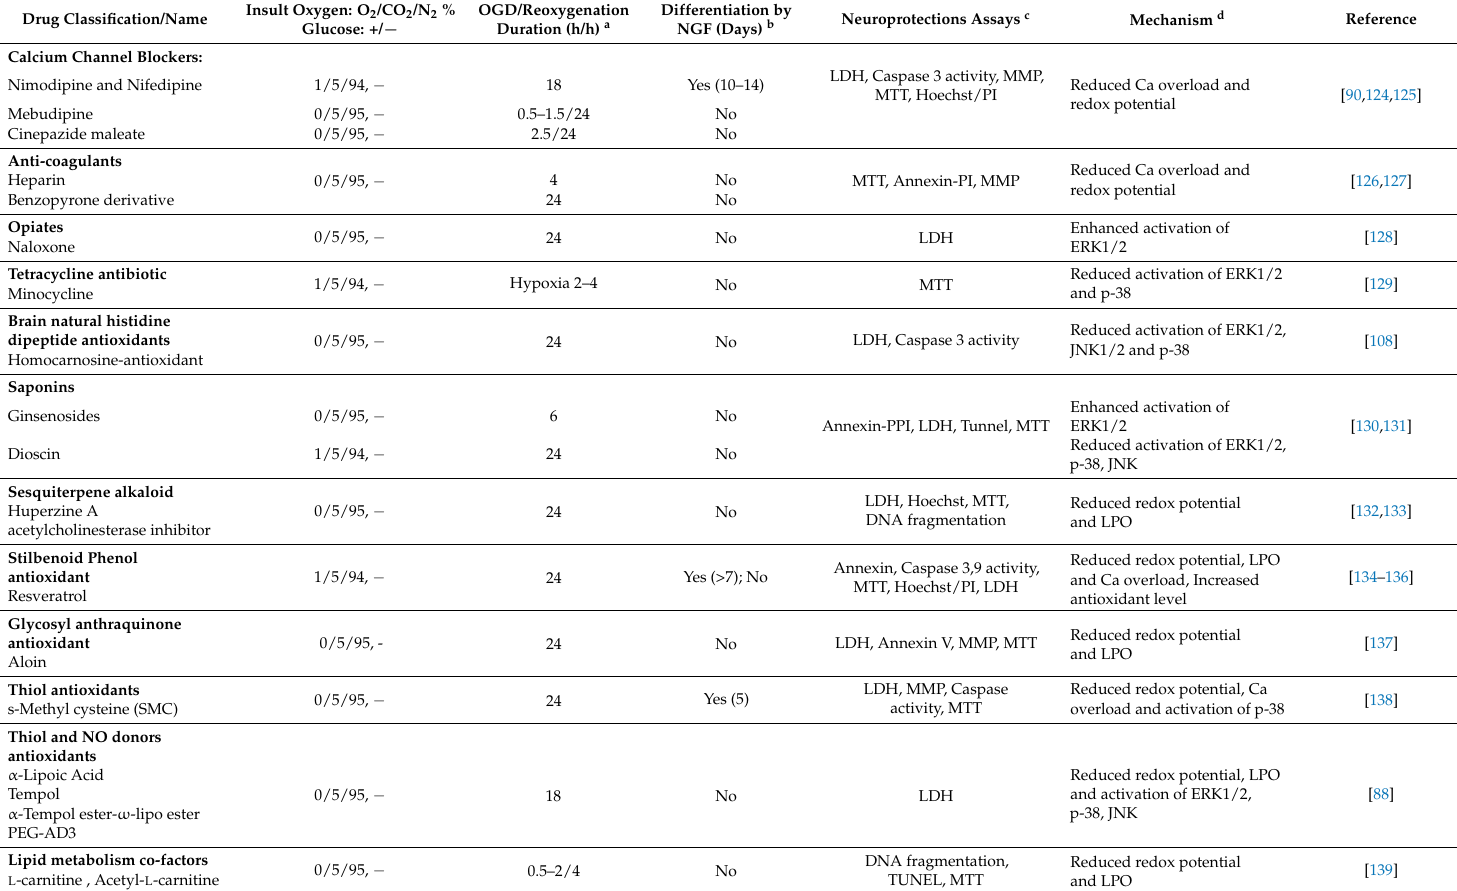
Table 1. Neuroprotective effect and proposed mechanism of different drugs and natural products using PC12 hypoxic and ischemic